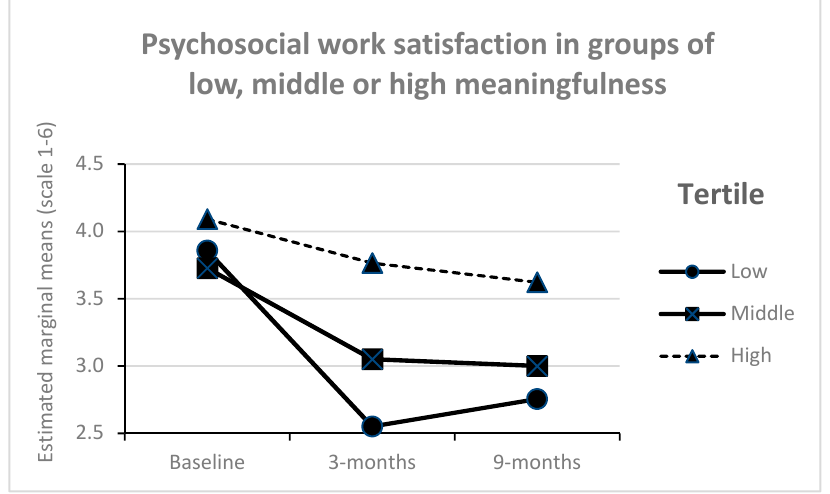
Figure 6. Psychosocial work satisfaction over time in groups with different levels of perceived meaningfulness in the process ( n = 246).